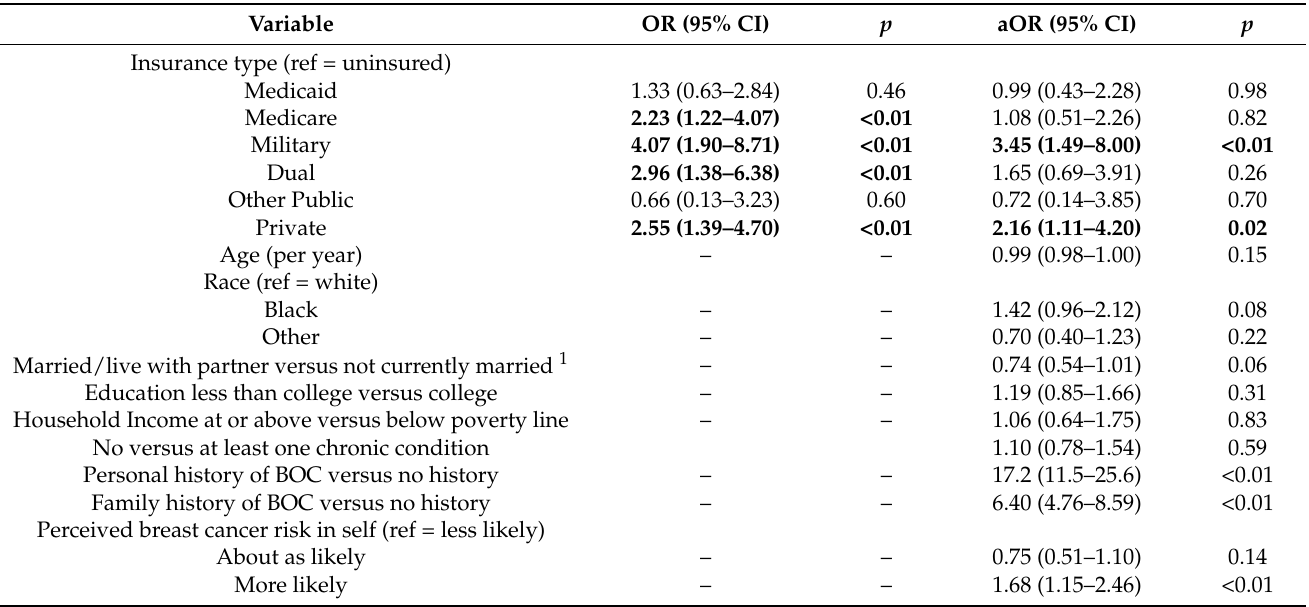
Table 2. Logistic regression evaluating association between the uptake of genetic testing/counseling for breast and/or ovarian cancer and health insurance type.